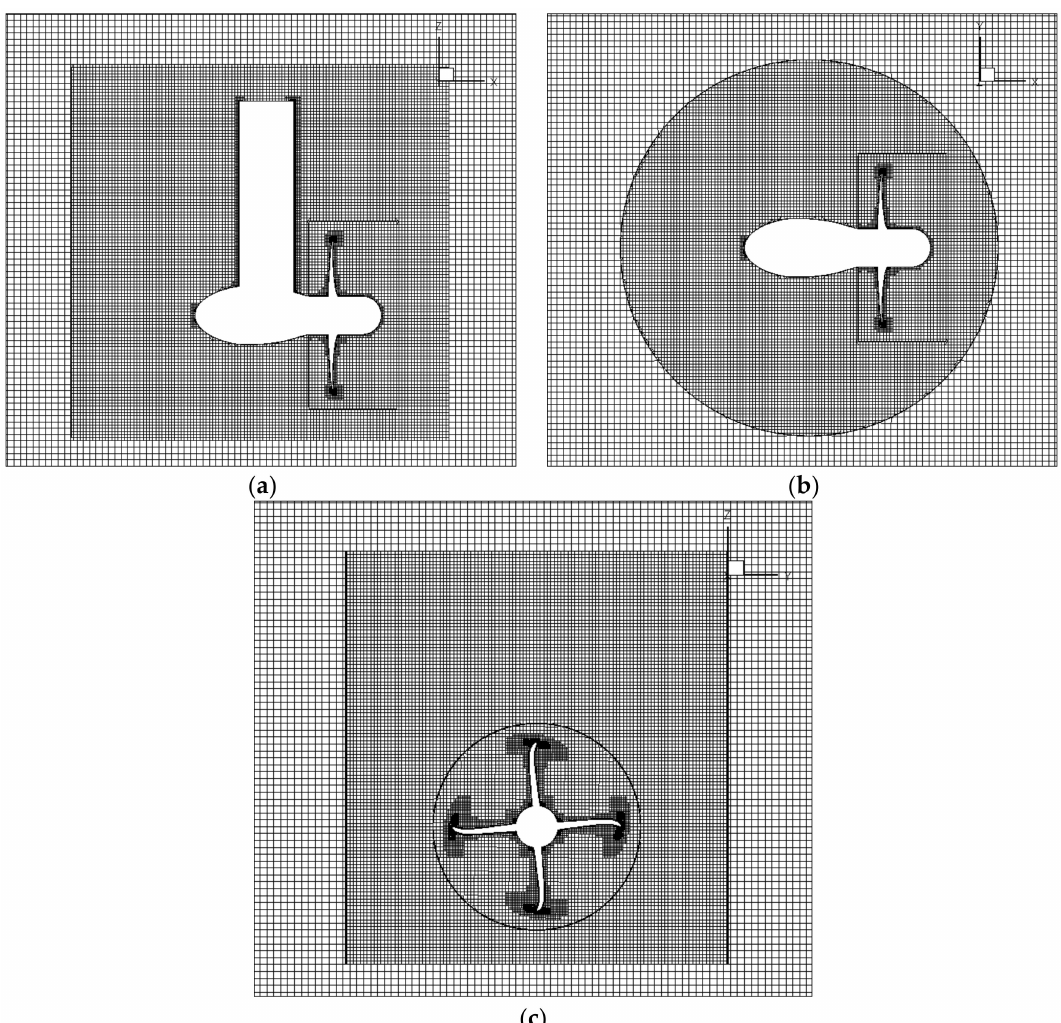
Figure 8. Fluid domain grid: ( a ) XZ plane ( b ) XY plane ( c ) YZ